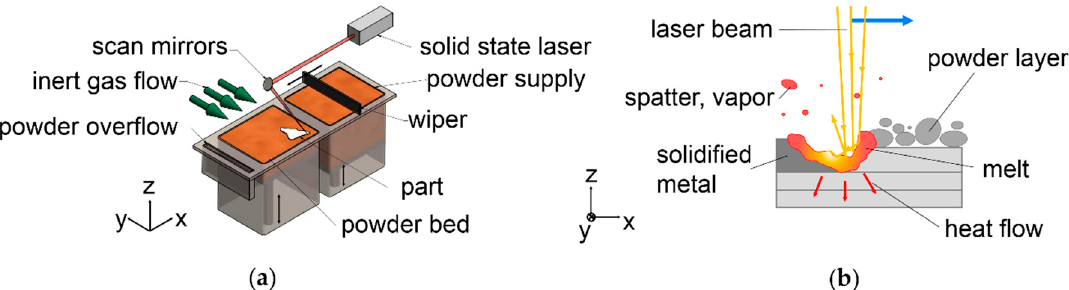
Figure 1. Laser Beam Melting in metal powder bed (LBM) fundamentals; ( a ) basic layout of an LBM machine; ( b ) basic interaction of laser beam (moving in direction of blue arrow), melt, powder and solidified metal in LBM.